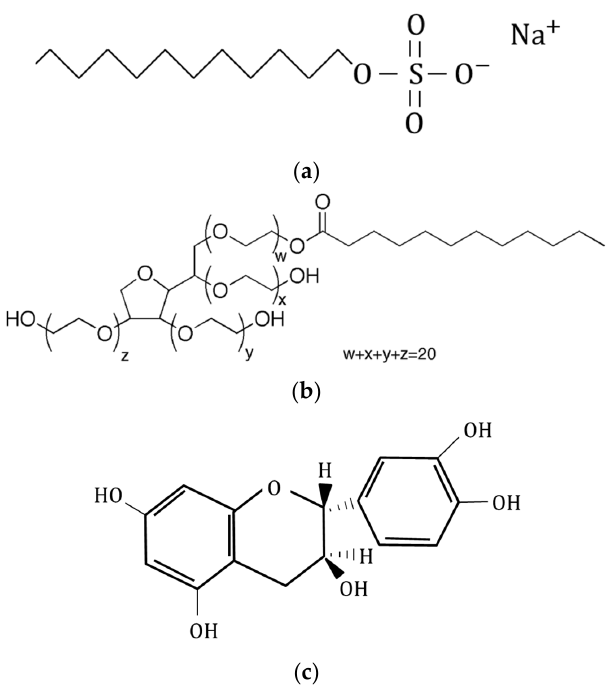
Figure 6. Structure of dispersants ( a ) SDS, ( b ) polysorbate 20, and ( c ) catechin.